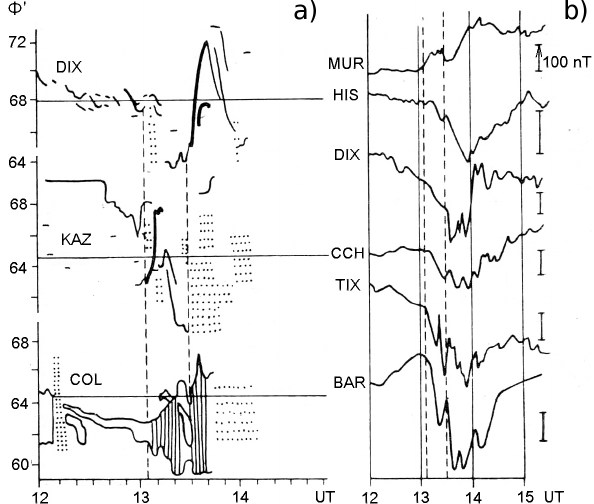
Figure 26. (a) Development of the auroral substorm on 6 De- cember 1958 from Dixon Island, Kazachye, and College ascafilms. (b) Magnetic field H component records from Murmansk, Heiss Is- land, Dixon Island, Cape Chelyuskin, Tixie Bay, and Point Barrow (Vorobjev and Rezhenov,